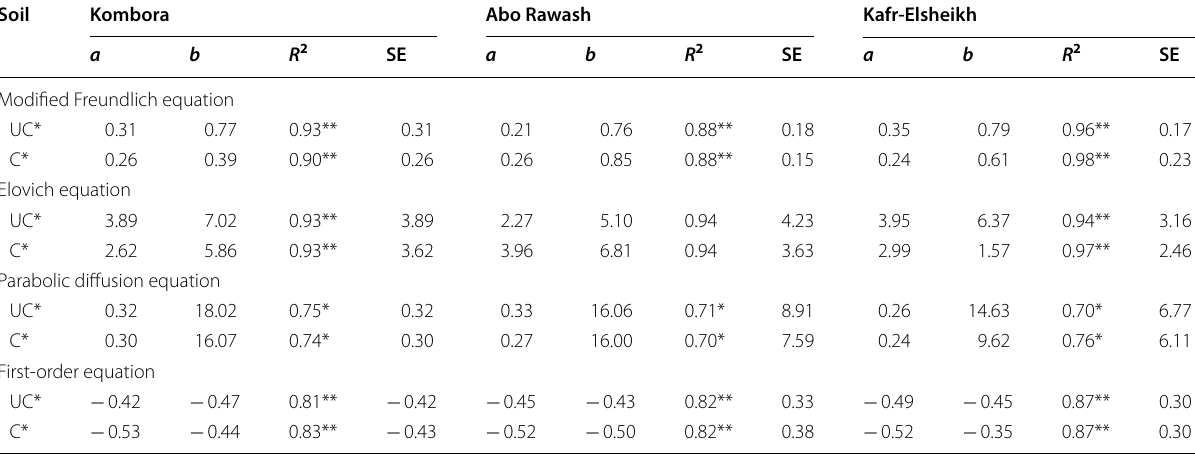
UC uncultivated soil, C cultivated soil